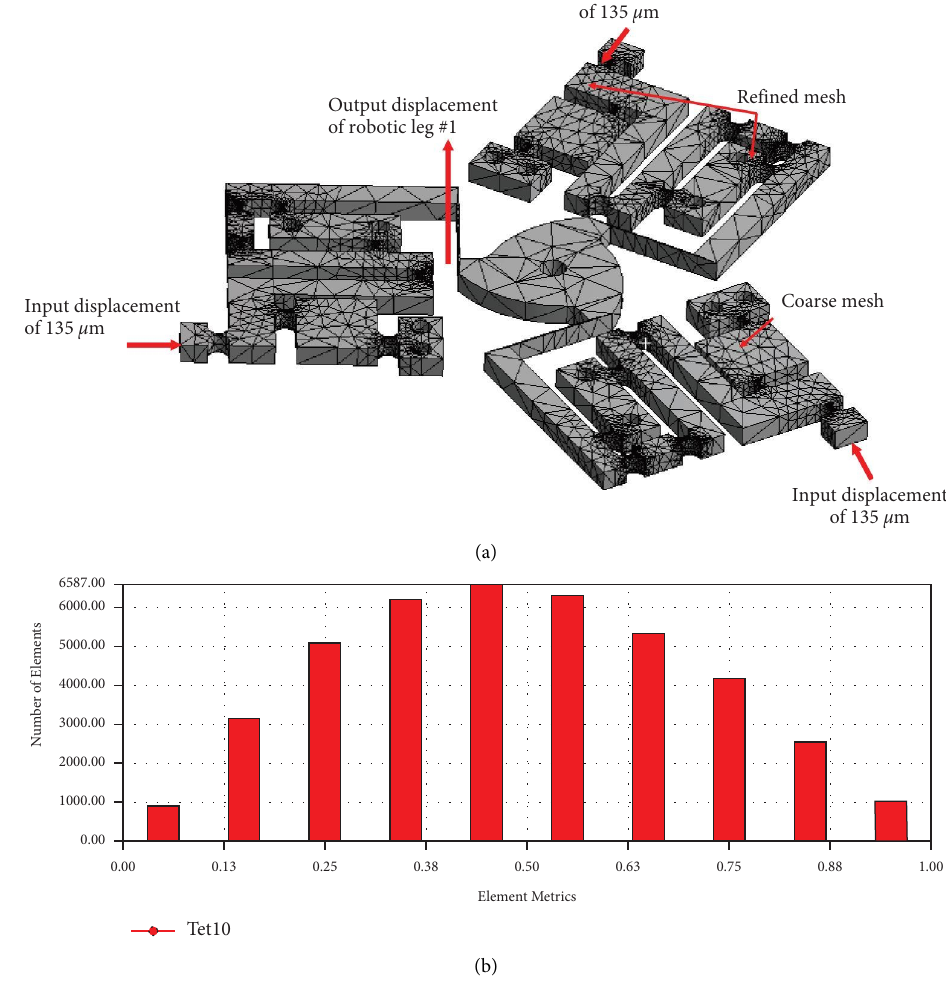
Figure 6: Simulation of the microrobotic platform: (a) boundary conditions, (b) mesh quality.